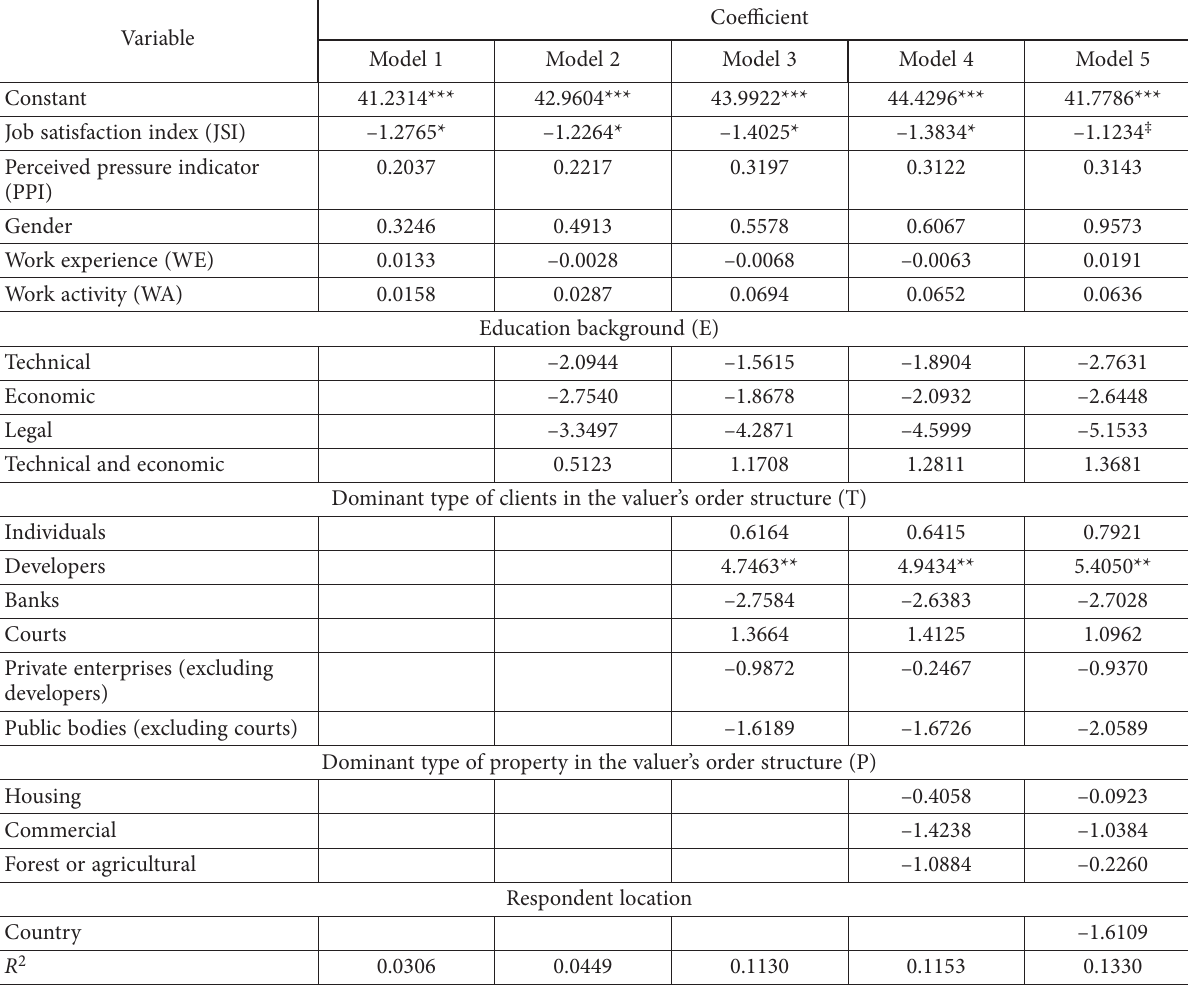
Table 3. Additional models estimates based on the 2SLS